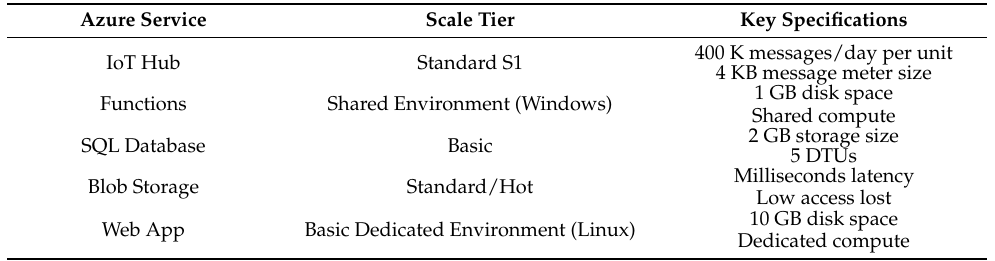
Table A1. A summary of scale tiers and key specifications of used Azure services in this